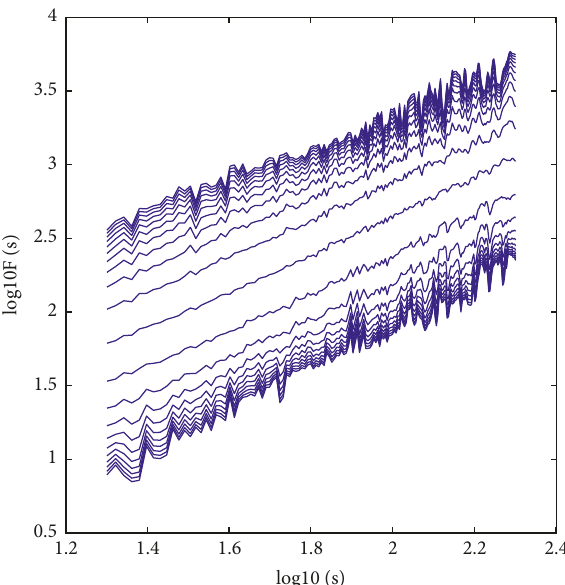
Figure 4: Log − log plot of F